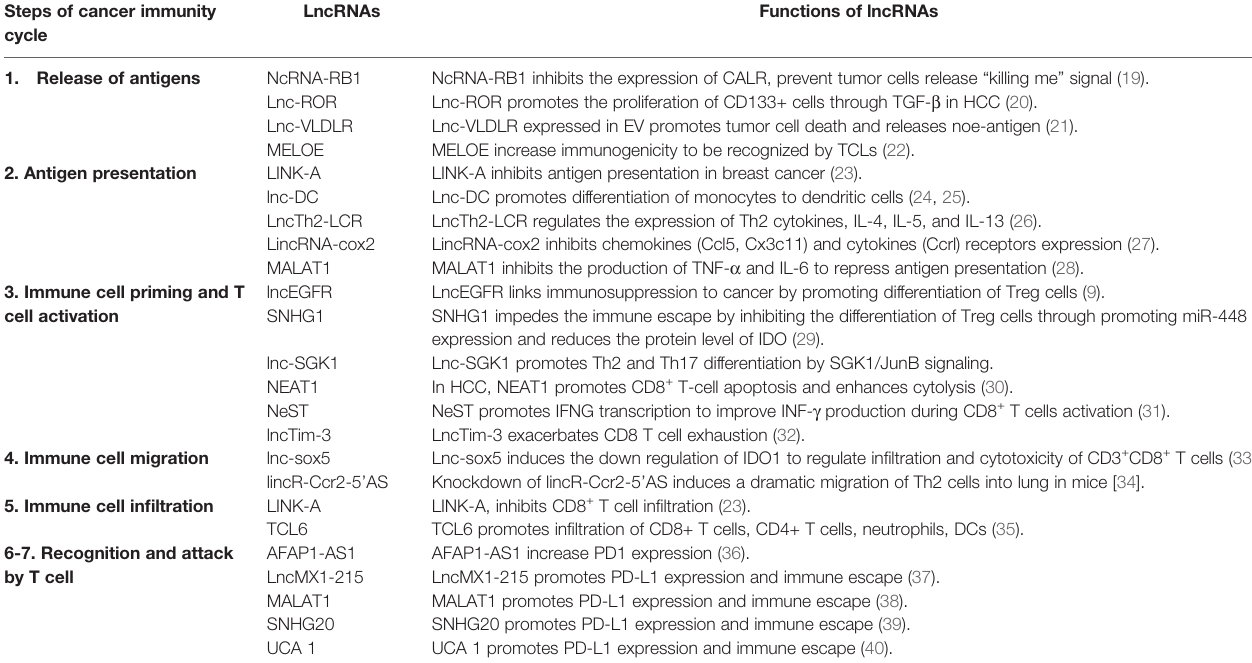
TABLE 1 | LncRNAs involved in cancer immunity and their functions.